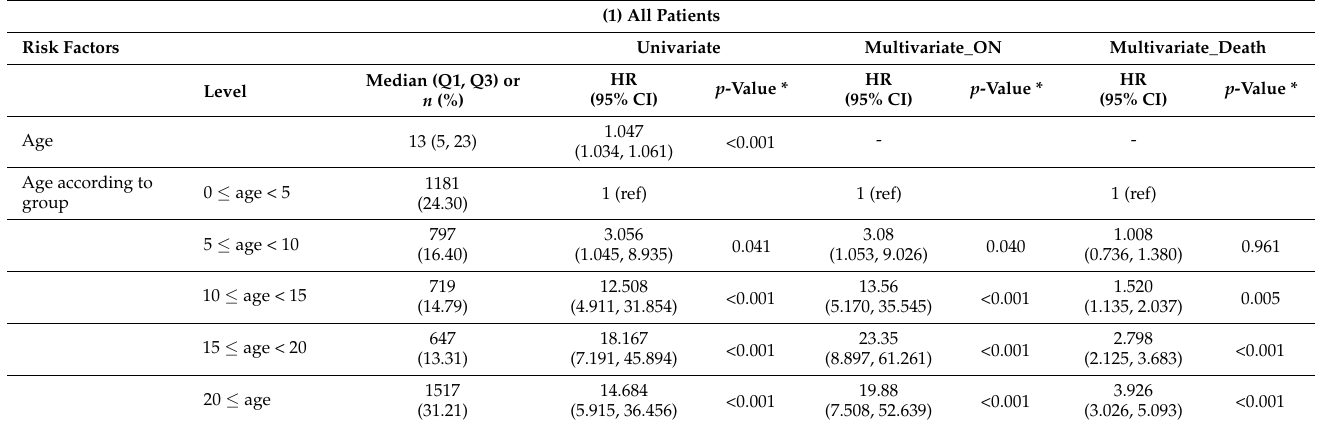
Table 3. Univariate and multivariate analysis associated with AVN. (1) All